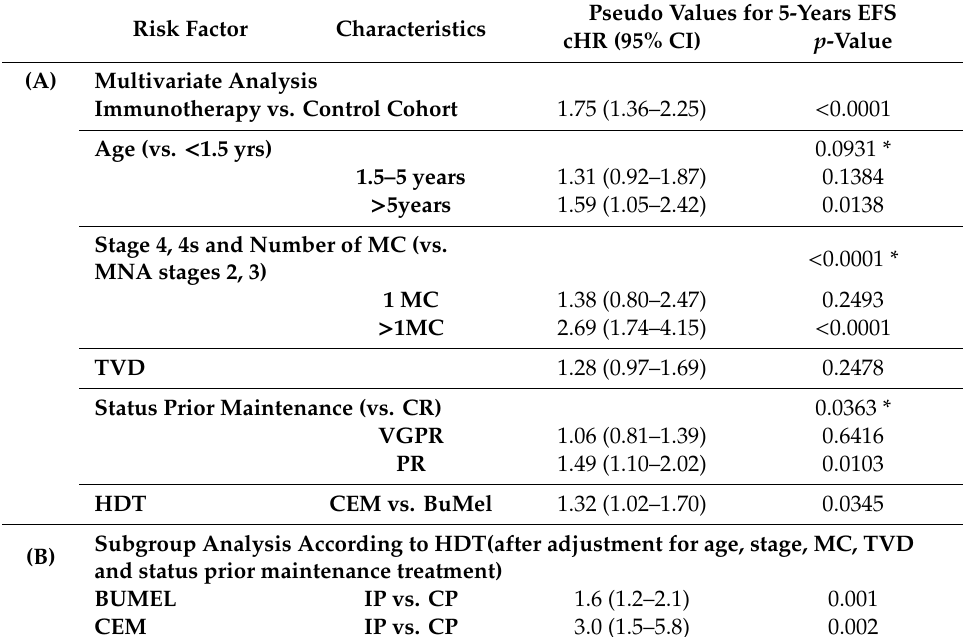
Table 3. Multivariate analysis of the analysis cohort. cHR (cumulative hazard ratios); 95% CI (95% confidence interval); p -value (probability value); MNA ( MYCN amplification); MC (metastatic compartments, referring either to bone marrow, skeletal or lymph node involvement); TVD (topotecan, vincristine and doxorubicin); CR (complete remission); VGPR (very good partial remission); PR (partial remission); HDT (high-dose chemotherapy); BuMel (high-dose chemotherapy with busulfan and melphalan); CEM (high-dose chemotherapy with carboplatin, etoposide and melphalan); IP (immunotherapy population) and CP (control population). * test for the global main e ff ect for risk-factors with more than two